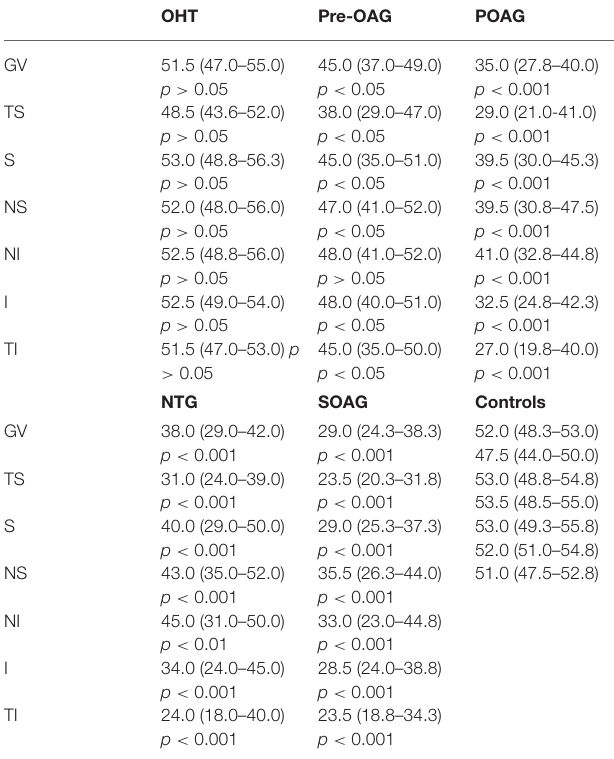
TABLE 3 | Global and sectorial RGCL thickness (median, quartiles; µ m) of all subgroups (OHT, pre-OAG, NTG, POAG, SOAG, controls); GV, global value; TS, temporal superior; S, superior; NS, nasal superior; NI, nasal inferior; I, inferior; TI, temporal inferior; p-values (p) for comparison of each subgroup with controls for quantitative RGCL thickness ([ µ m],